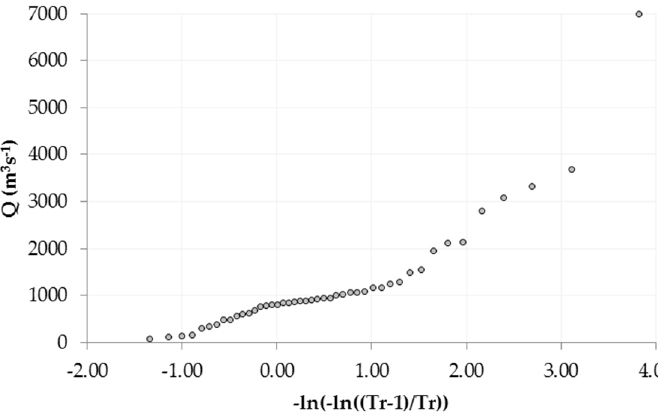
Figure 2. Reduced variable for maximum annual flows of hydrometric station 10040.